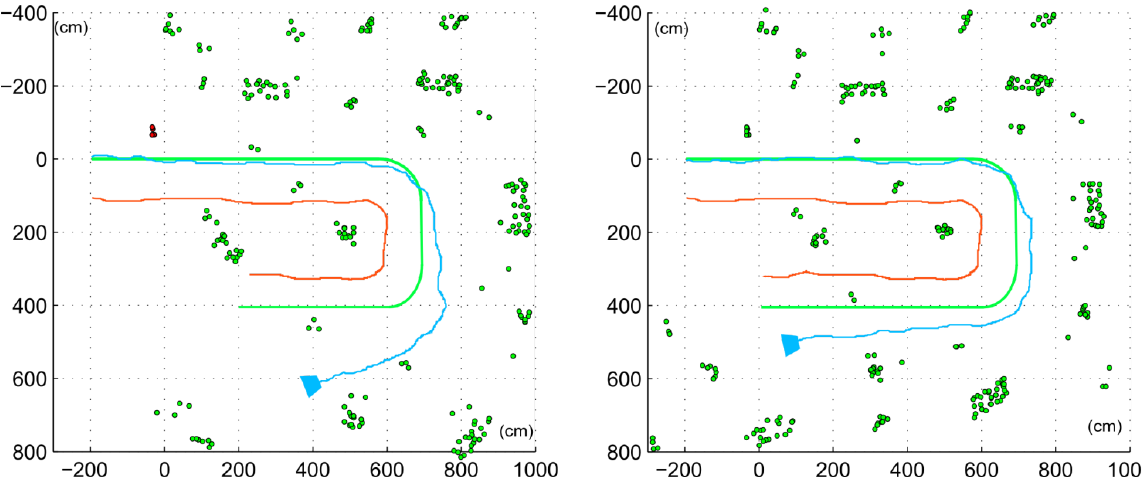
Figure 11. Trajectory estimated with classical DI-D monocular SLAM ( left ) and with the new non-constant stereo I-D approach. Green line denotes robot ground truth, orange line denotes C ground truth, and the estimated C trajectory is shown in blue. Red features f s (only in left plot) have been artificially calibrated and introduced to have an initial scale estimation in the DI-D approach.